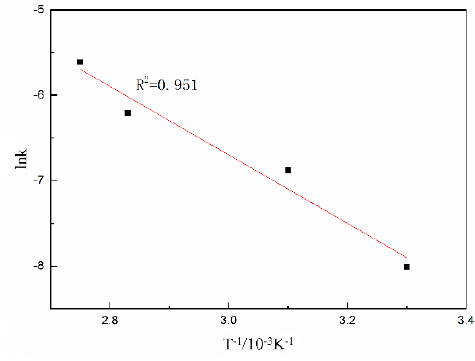
Figure 8. Arrhenius plot for nickel leaching.